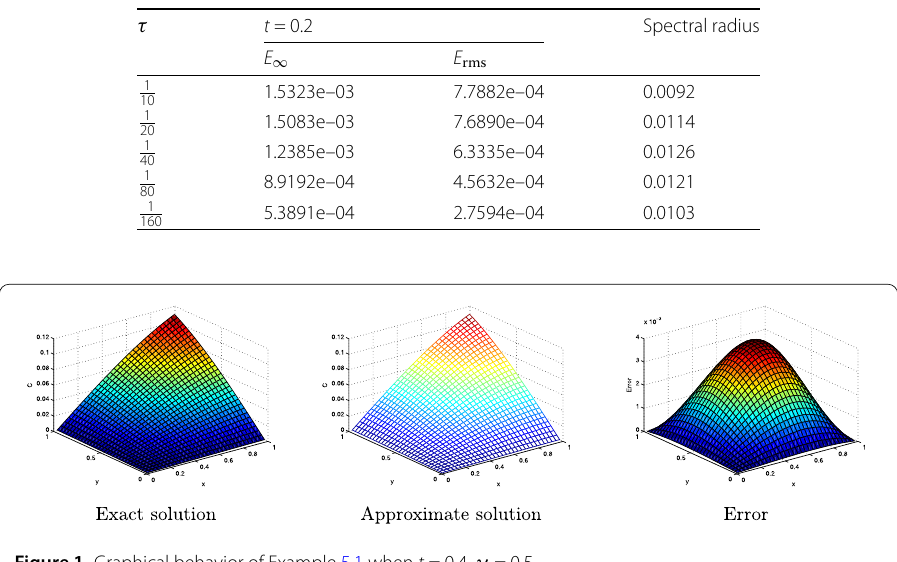
Table 2 Error norms of Example 5.1 at γ = 0.75, θ = 1